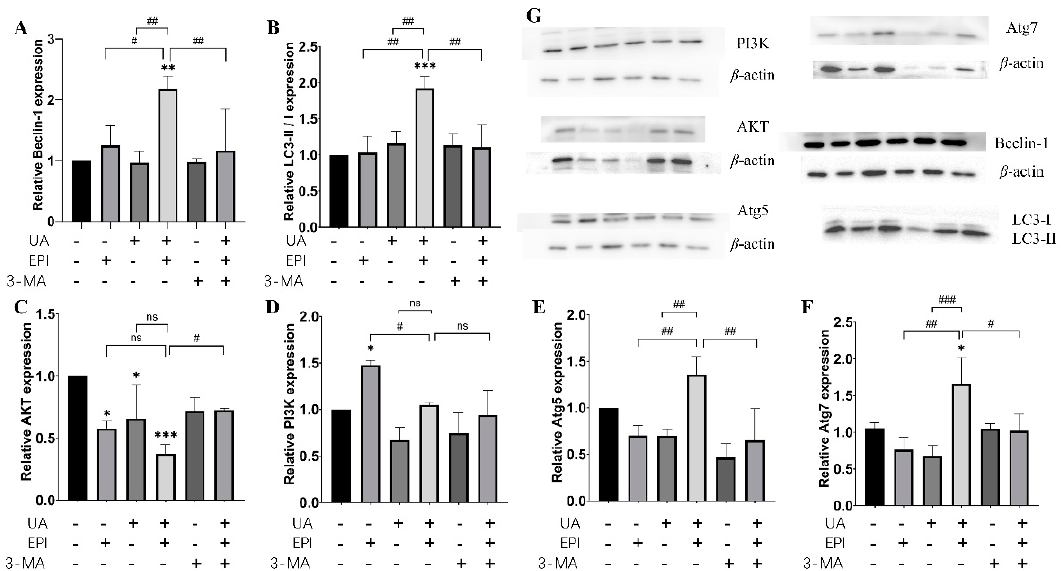
Figure 6. Changes in the expression levels of autophagy-related protein in MCF-7 cells. Western blot analysis was used to measure autophagy-related protein expression levels in MCF-7 cells. ( A ) Quantification of Beclin-1 protein expression levels in MCF-7 cells. ( B ) Quantification of LC3-II/I protein expression levels in MCF-7 cells. ( C ) Quantification of AKT protein expression levels in MCF-7 cells. ( D ) Quantification of PI3K protein expression levels in MCF-7 cells. ( E ) Quantification of Atg5 protein expression levels in MCF-7 cells. ( F ) Quantification of Atg7 protein expression levels in MCF-7 cells. ( G ) Representative pictures of Beclin-1, LC3-II/I, AKT, PI3K, Atg5, Atg7 expression by Western blot. The means and SEM were shown. n = 3. * p < 0.05, ** p < 0.01 and *** p < 0.001 versus control group in the absence of any treatments; # p < 0.05, ## p < 0.01 and ### p < 0.001. The value bars with ns are not significant.